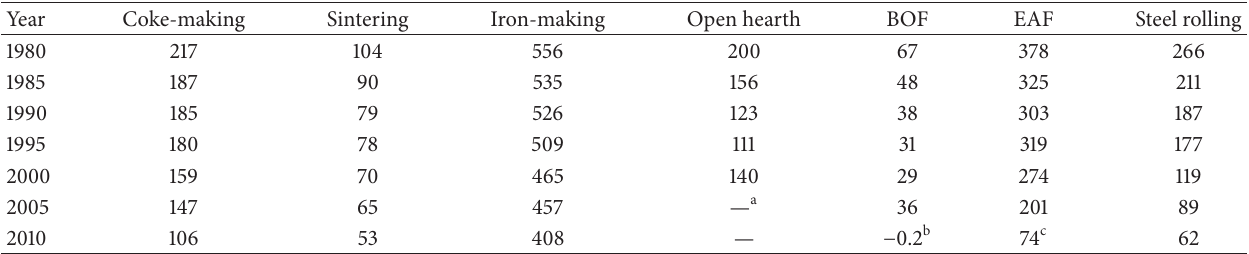
Table 2: Process energy consumptions of CSI during 1980–2010